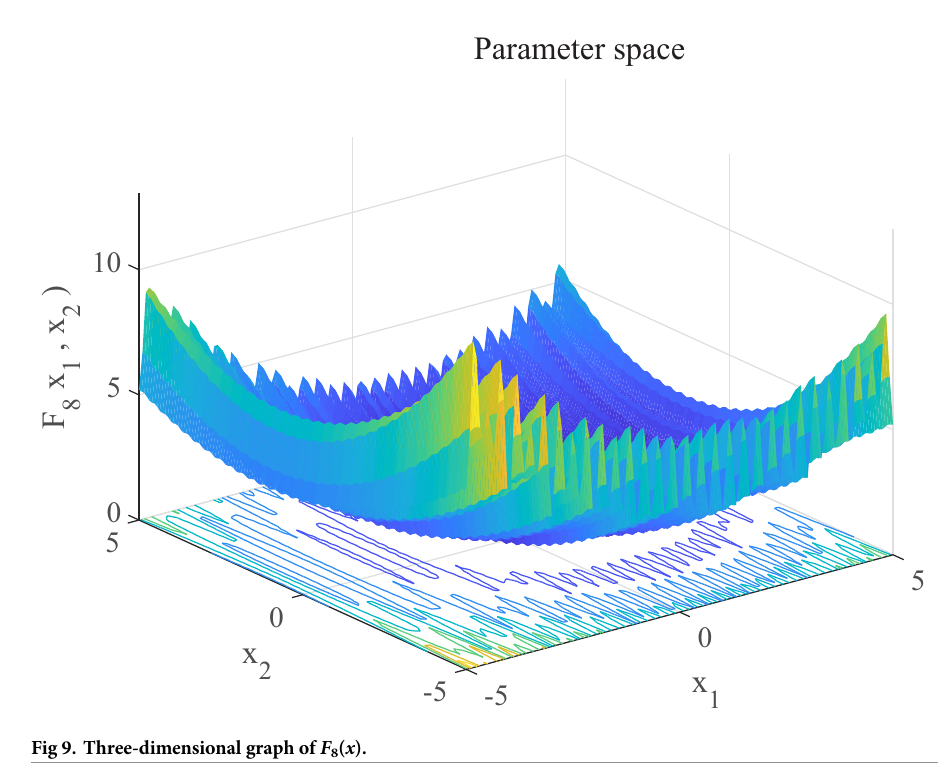
Fig 9. Three-dimensional graph of F 8 ( x ).